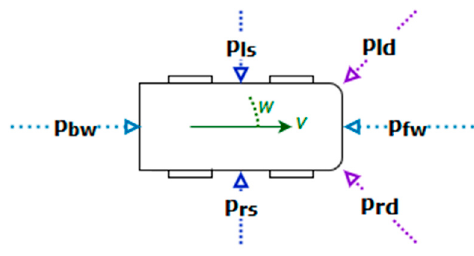
Figure 1. General schema of the different potential field sources.